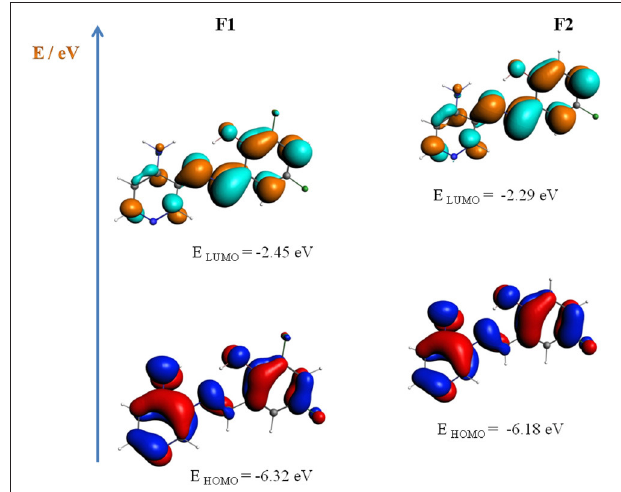
FIGURE 2 | Molecular models for F1 and F2 compounds. The energy of the frontier orbital HOMO-LUMO is presented in eV.